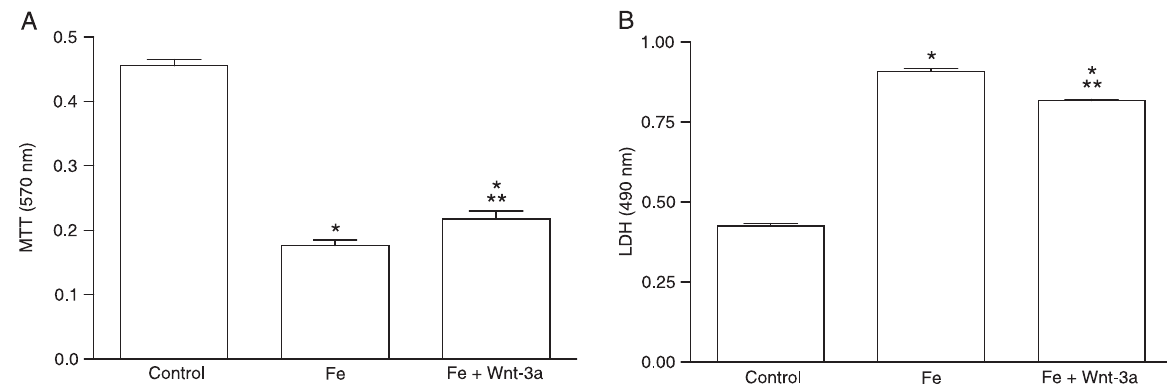
Figure 4. Wnt-3a peptide reduced the loss of cell viability induced by 10 mM FeSO 4 (Fe). A , B , PC12 cells were incubated with 10 mM FeSO 4 24 h after the addition of mouse recombinant Wnt-3a peptide (100 ng/mL). Twenty-four hours later, cell viability was measured by A , MTT reduction (570 nm) and B , by lactate dehydrogenase (LDH) release (490 nm). Data are reported as means ± SEM for 6 inde- pendent experiments. *P < 0.001 vs control (vehicle: water); **P < 0.05 vs Fe (one-way ANOVA followed by the Newman-Keuls test).